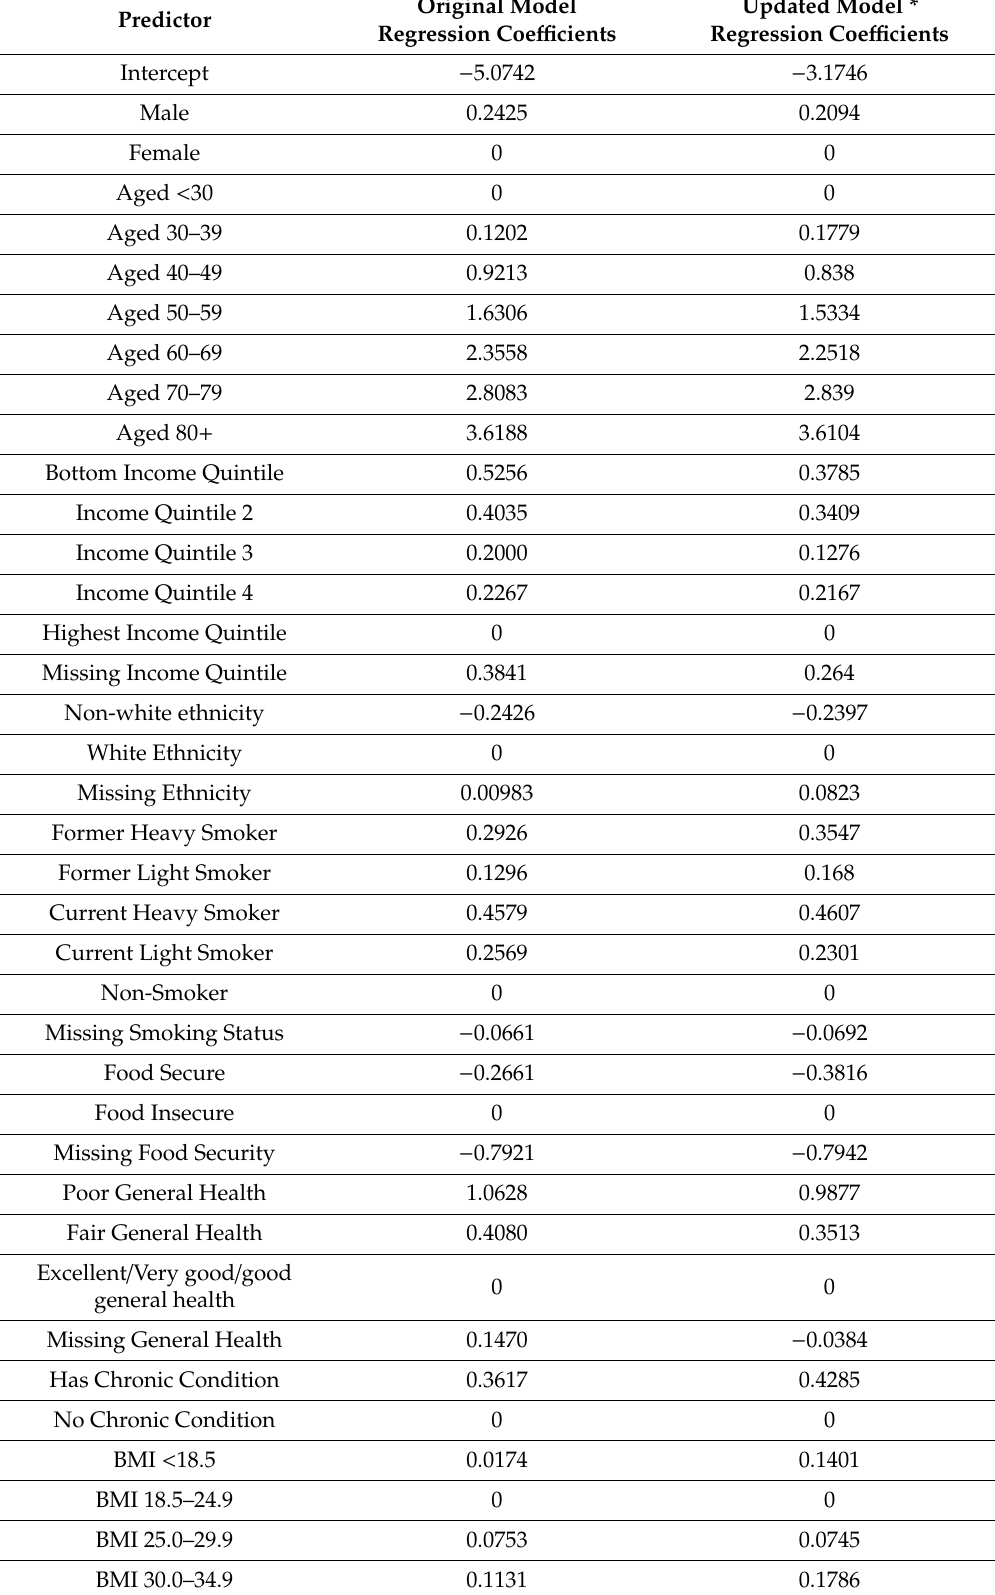
Table A1. Predictors and regression coe ffi cients of the original and updated HRUPoRT